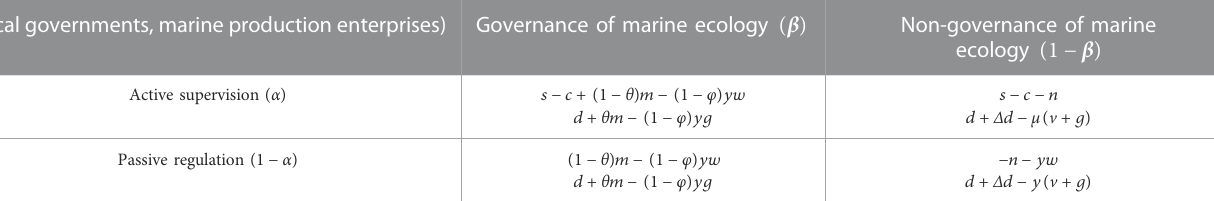
TABLE 3 Income payment matrix of local governments and marine production enterprises. (Local governments, marine production enterprises) Governance of marine ecology ( β ) Non-governance of marine Active supervision ( α